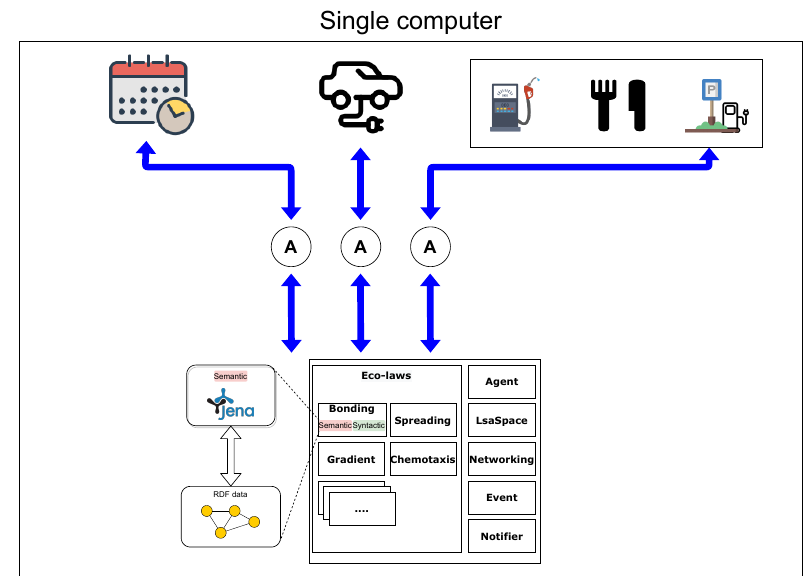
Figure 10. Deployment on a single